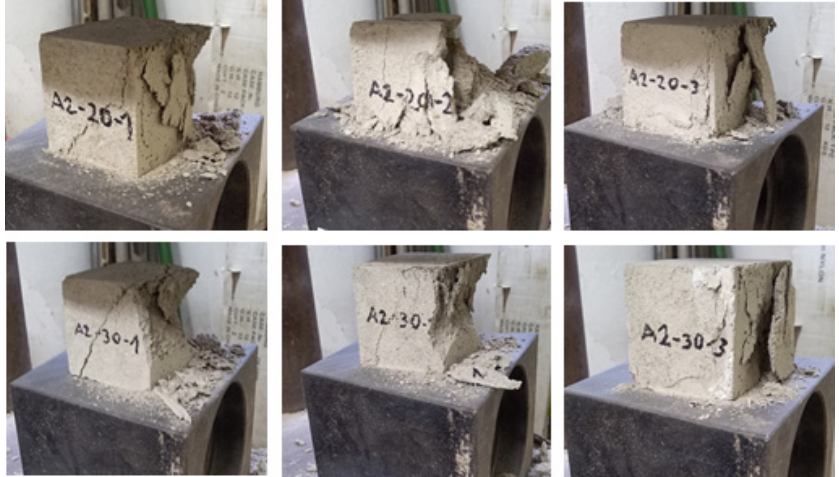
Figure 6. Impression of selected UCS specimens of the ash test series, here cubes having a filter ash share of 20 and 30%.